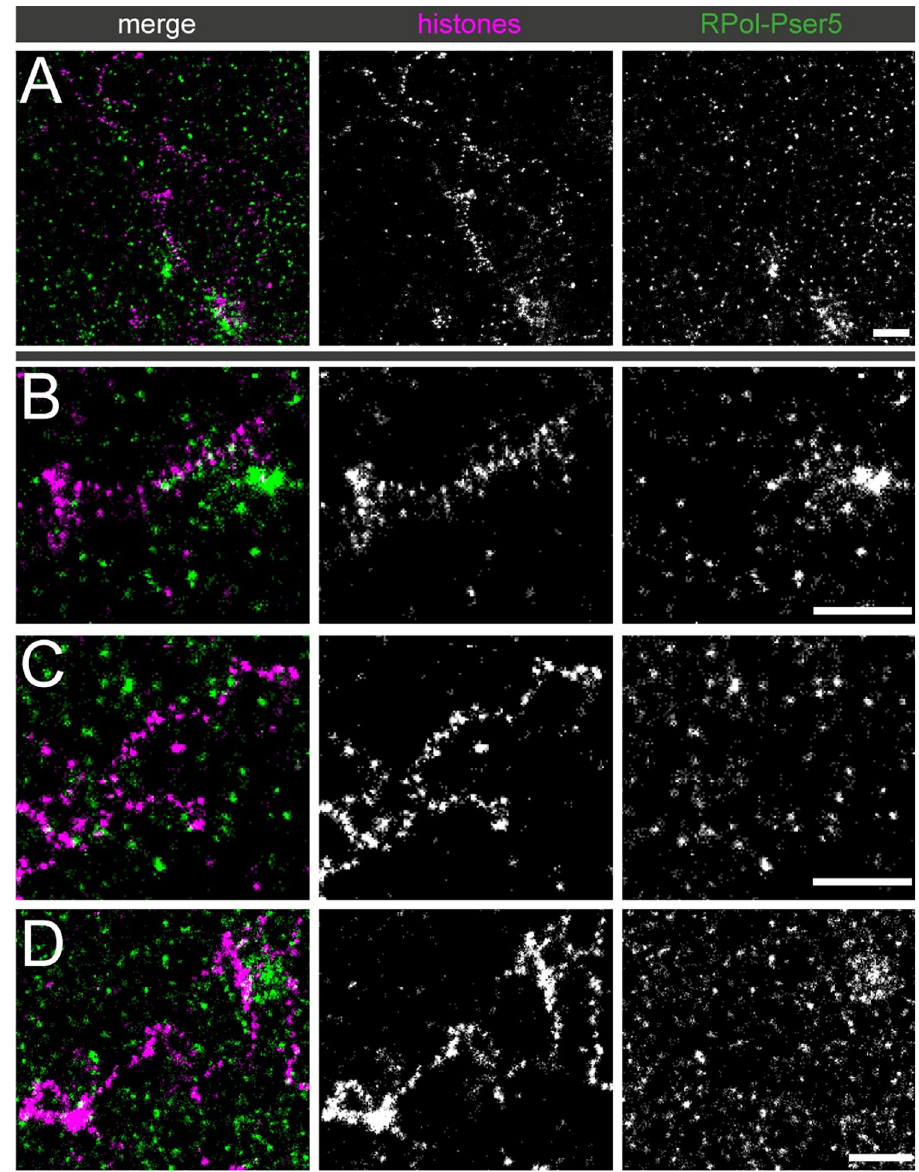
Fig 7. Association of Y loops to RPol-PSer5. Dual-colour STORM images of immunolabelled histones (magenta) and RPol-Pser5 (green). (A) gives an overview and (B to D) show selected examples at higher power. Although RPol-PSer5 foci appear to be more prevalent than RPol-PSer2 foci, they are generally not present between the nucleosome clusters. In addition many RPol-PSer5 foci appear distant from chromatin fibres. Scale bars are 1 μ